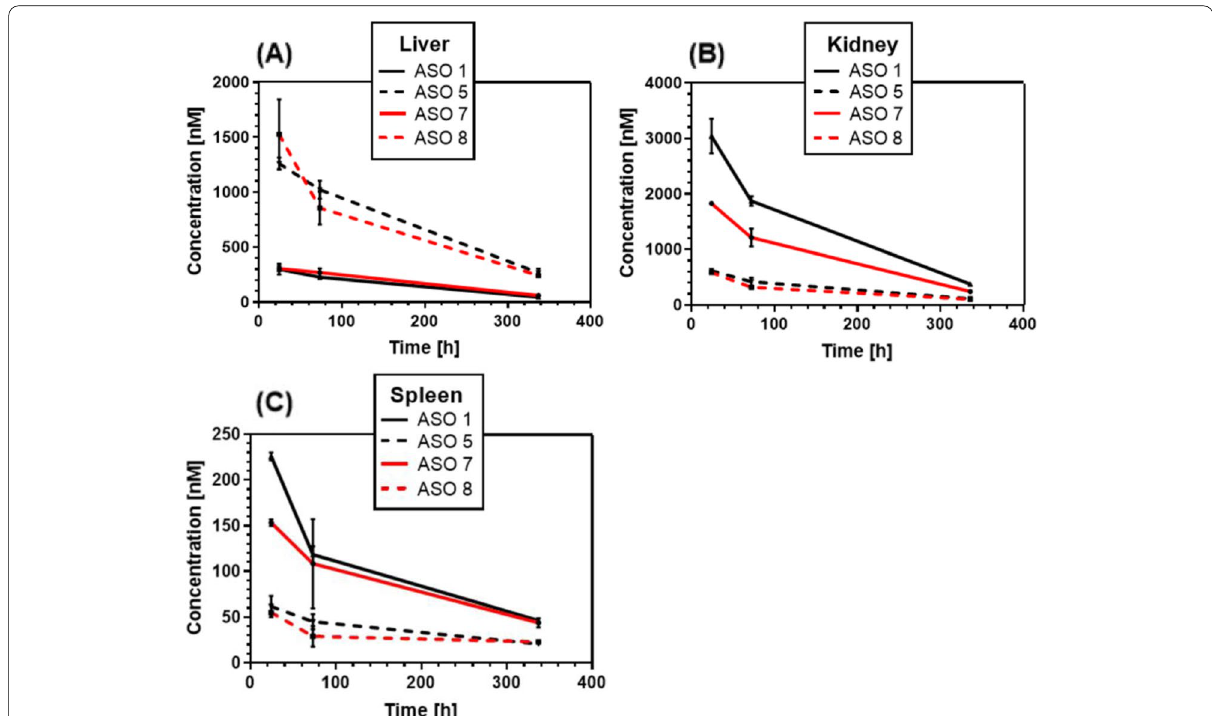
Fig. 5 Tissue exposure of untagged ASOs 1 (naked), 5 (GalNAc), and tritium-tagged ASOs 7 (naked), 8 (GalNAc) in A liver, B kidney, and C spleen (mean, n =